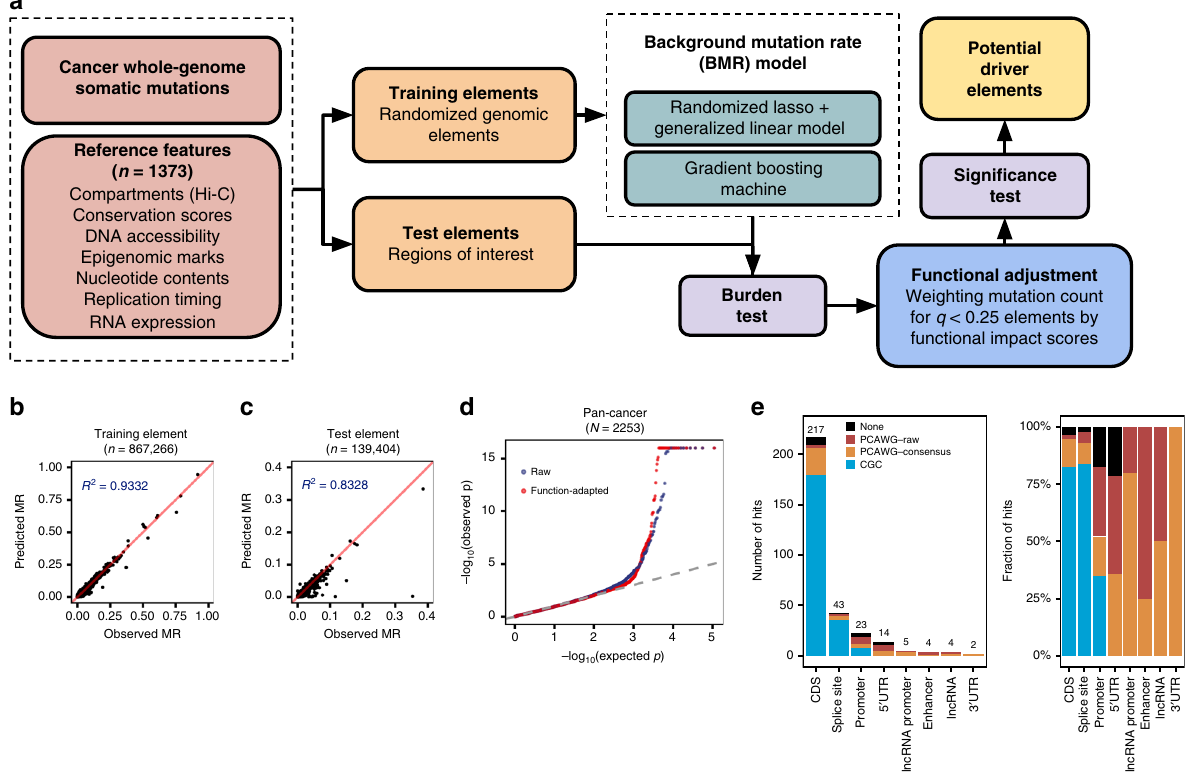
Fig. 1 Summary of method and results. a DriverPower overview. b , c For the training and test element sets, comparison of the predicted ( Y axis) and observed ( X axis) mutation rate in the pan-cancer cohort. d The raw and function-adapted p value quantile-quantile (QQ)-plot for all test elements in the pan-cancer cohort. Function-adapted p values are p values with the incorporation of functional impact scores. e Number and fraction of non-coding driver candidates called by DriverPower contained within three reference driver sets (CGC, PCAWG-consensus or PCAWG-raw). For each element type, the number of candidates is also shown above the